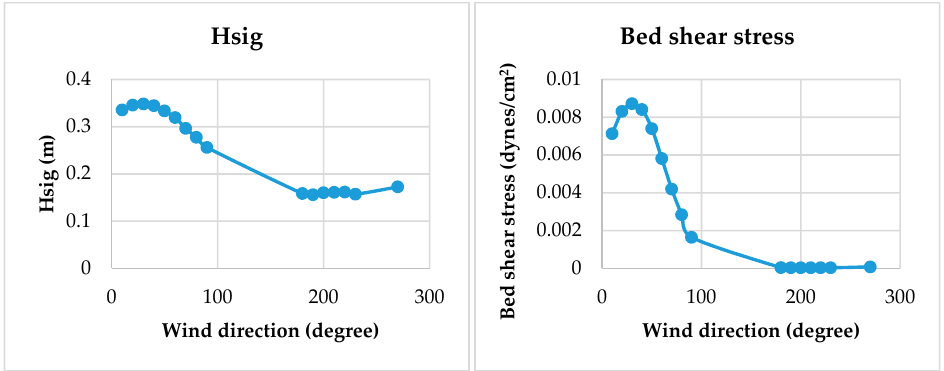
Figure 13. Variations of significant wave height and bed shear stress to different wind directions (at station 296,437.06 lat. 1,308,613.36 long.) in NE and SW monsoons.